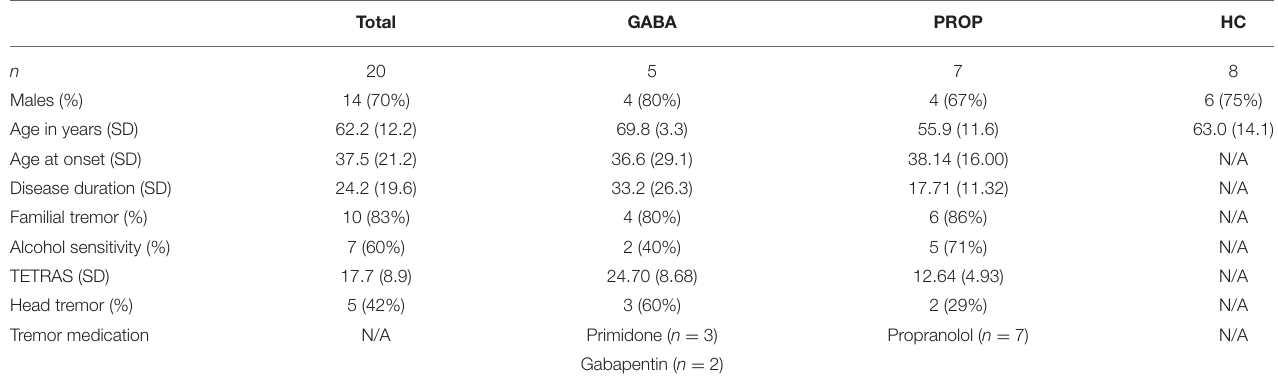
TABLE 1 | Demographical data of total included subjects ( n = 20) and subject groups.